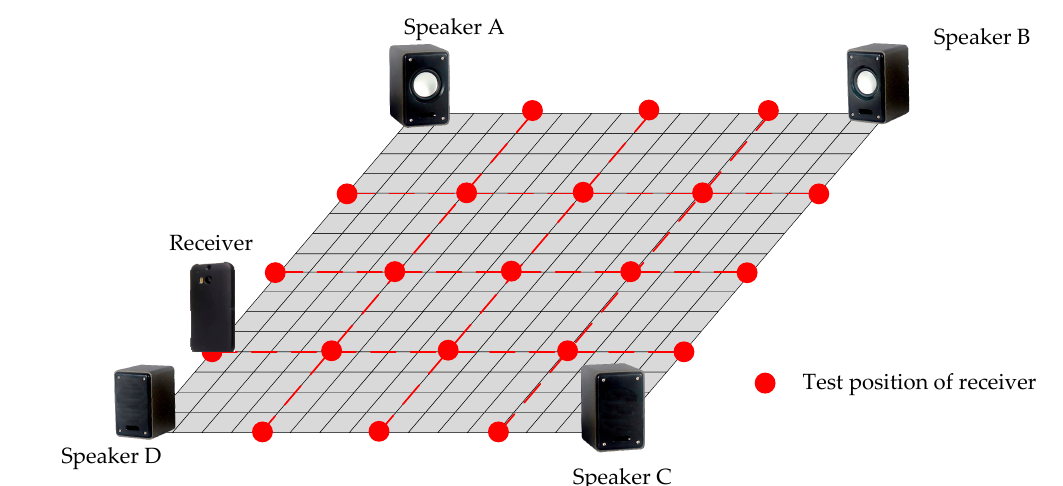
Figure 6. The sketch of the first experiment.